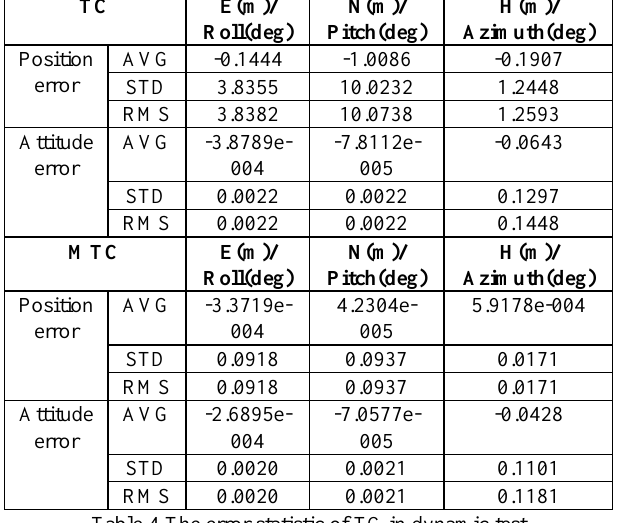
Table 4 The error statistic of TC in dynamic test